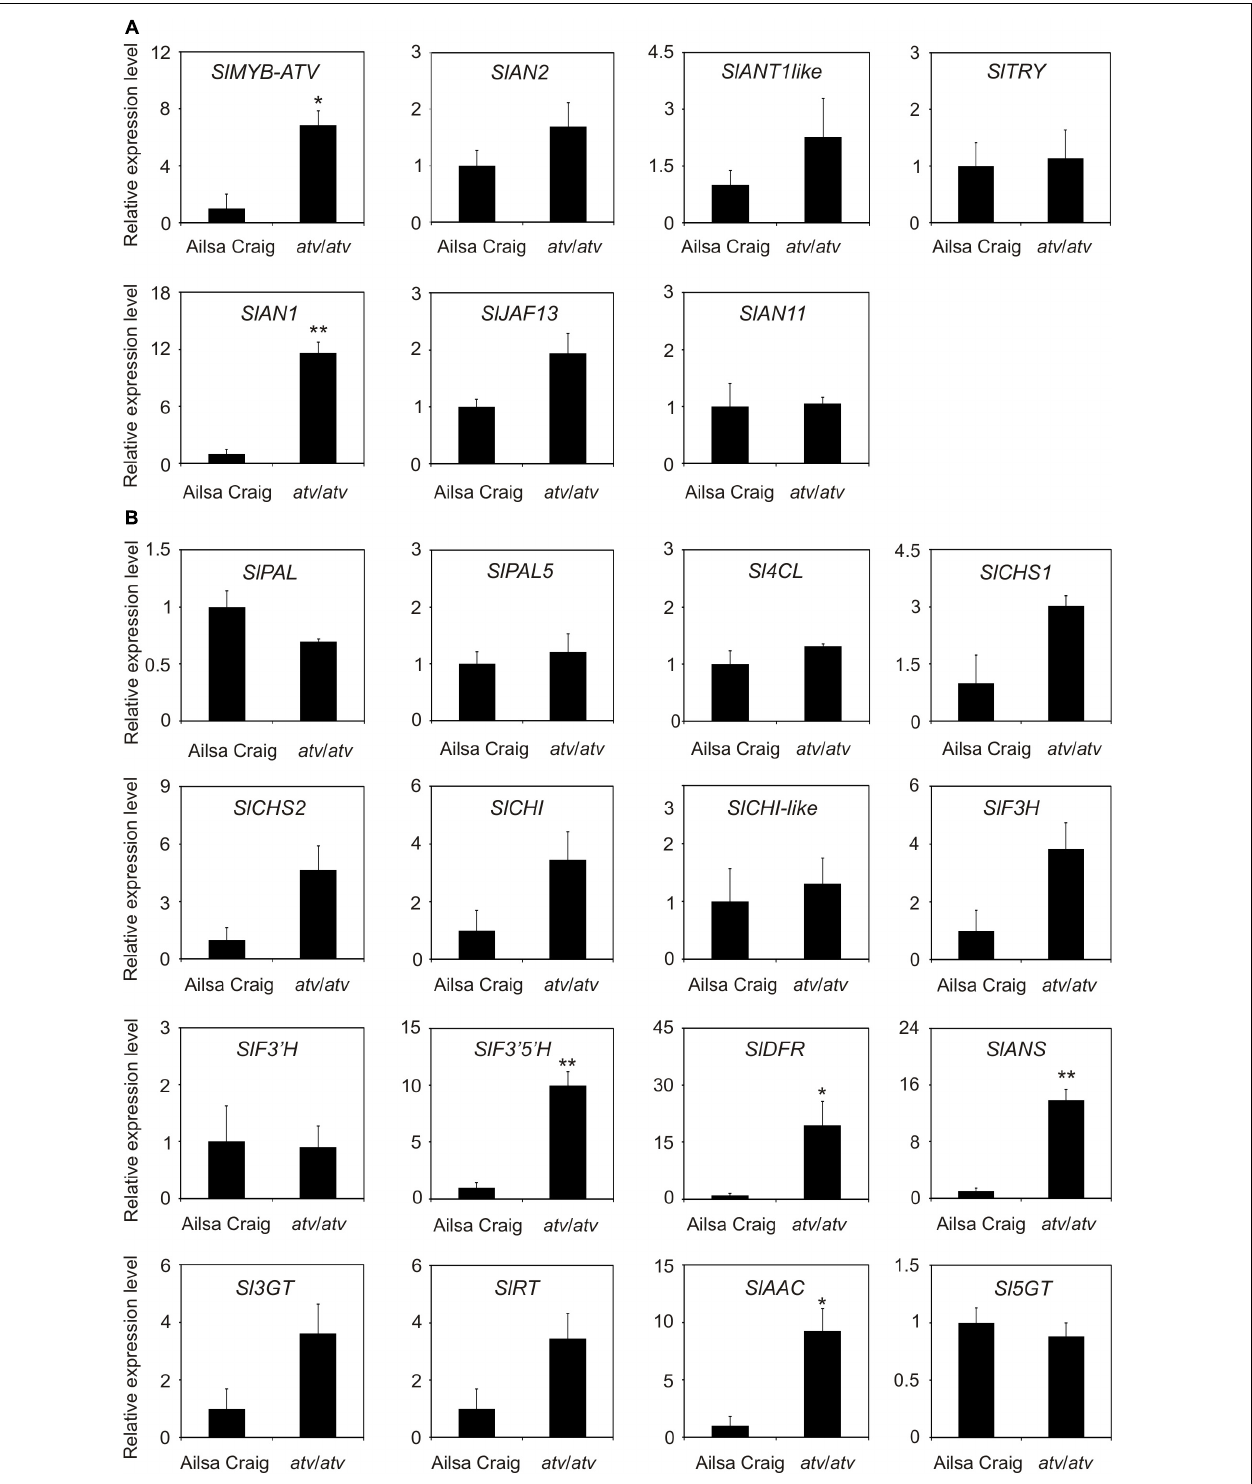
FIGURE 5 | In atv mutant plants both regulatory and structural genes of the anthocyanin biosynthetic pathway are induced. Quantitative analysis of transcript levels of (A) regulatory and (B) structural genes in Ailsa Craig (AC) and atv / atv plants (in AC background) grown for two months under 12 h light photoperiod with a light intensity of approx. 300 µ mol photons m 2 s − 1 , and 24 ◦ C/21 ◦ C day/night temperature. Expression levels, measured by qPCR, are shown as relative units, with the average value of the biological replicates of AC sample set to one. Data are means of three biological replicates (single mature leaves from different plants) ± SE. Unpaired t -test was carried out and single asterisks ( P < 0.05) and double asterisks ( P < 0.01) indicate significant differences.